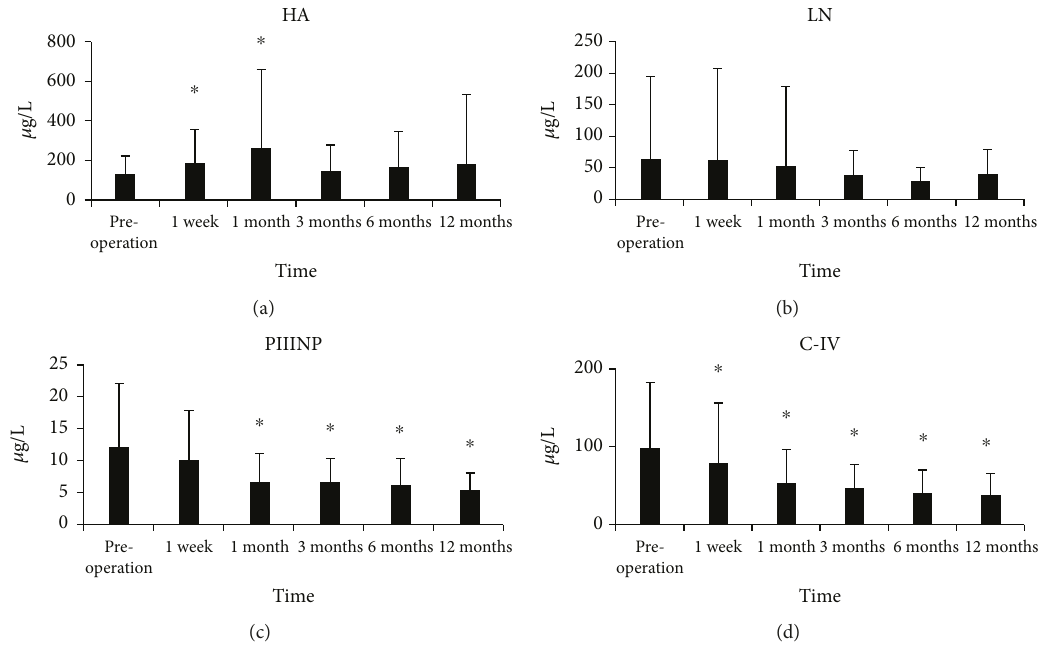
Figure 1: The changes in patients ’ serum markers, including HA (a), LN (b), PIIINP (c), and C-IV (d). ∗ P < 0 05 compared to preoperation. The numbers of compared pairs of all serum markers at 1 week, 1 month, 3 months, 6 months, and 12 months were 48, 39, 30, 27, and 15, respectively. The sample sizes of HA were 51, 50, 40, 32, 29, and 16 to preoperation, 1 week, 1 month, 3 months, 6 months, and 12 months, respectively. The sample sizes of LN were 51, 50, 40, 32, 29, and 16 to preoperation, 1 week, 1 month, 3 months, 6 months, and 12 months, respectively. The sample sizes of PIIINP were 51, 50, 40, 32, 29, and 16 to preoperation, 1 week, 1 month, 3 months, 6 months, and 12 months, respectively. The sample sizes of C-IV were 51, 50, 40, 32, 29, and 16 to preoperation, 1 week, 1 month, 3 months, 6 months, and 12 months, respectively.